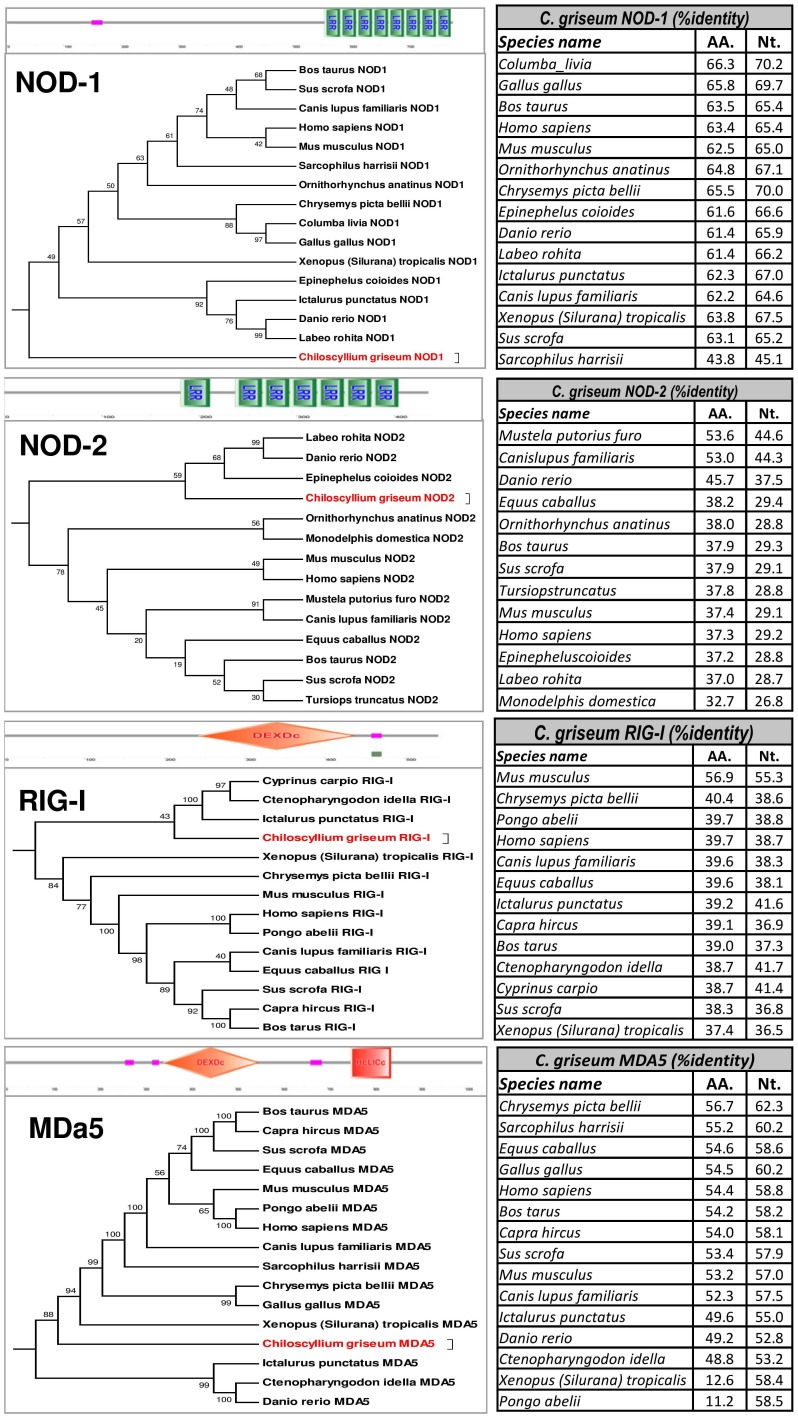
SMART domain prediction and percentage identity of the intra-cytoplasmic pattern recognition receptor transcripts of Chiloscyllium griseum identified from the transcriptome data – NOD1, NOD2, RIG-I and MDA5.The sequences of the receptors NOD1 (2838 nt), NOD2 (1308 nt), RIG-I (1599 nt) and MDA5 (3117 nt) of C. griseum was used to predict the domains. The identity of these receptors ranged from 53.6% (NOD2), MDA5 (56.7%), 56.9% (RIG-I) and 66.35 (for NOD1). The corresponding nucleotide and amino acid identity of the C. griseum transcripts is also provided for each of the receptor type with some of the important species (further details in Table S13).